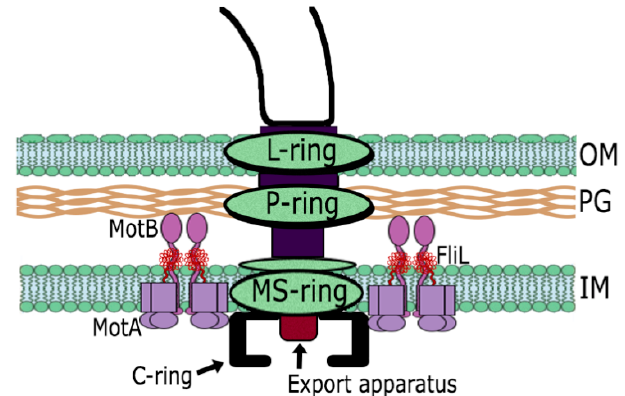
Figure 1. Scheme of the bacterial flagellum that shows the most relevant elements of the core structure that is common to several species of Gram-negative